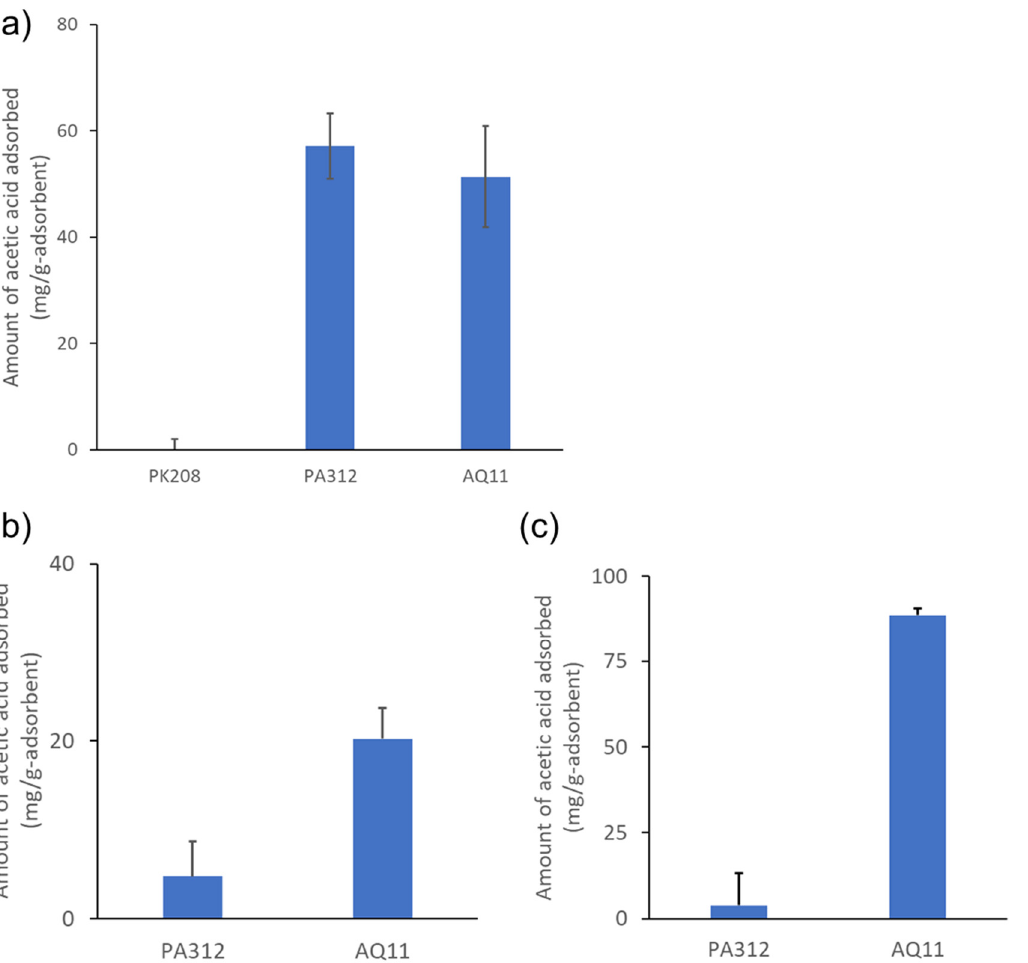
Figure 4. Comparison of adsorption by AQ11 and ion exchange resins. ( a ) Comparison of PK208, PA312, and AQ11 in a 10 g/L acetic acid solution at pH 7.0. ( b ) Comparison of PA312 and AQ11 in a culture medium. ( c ) Comparison of PA312 and AQ11 in an acetic acid solution (10 g/L) without adjusting the pH (the pH of the solution was 2.9).